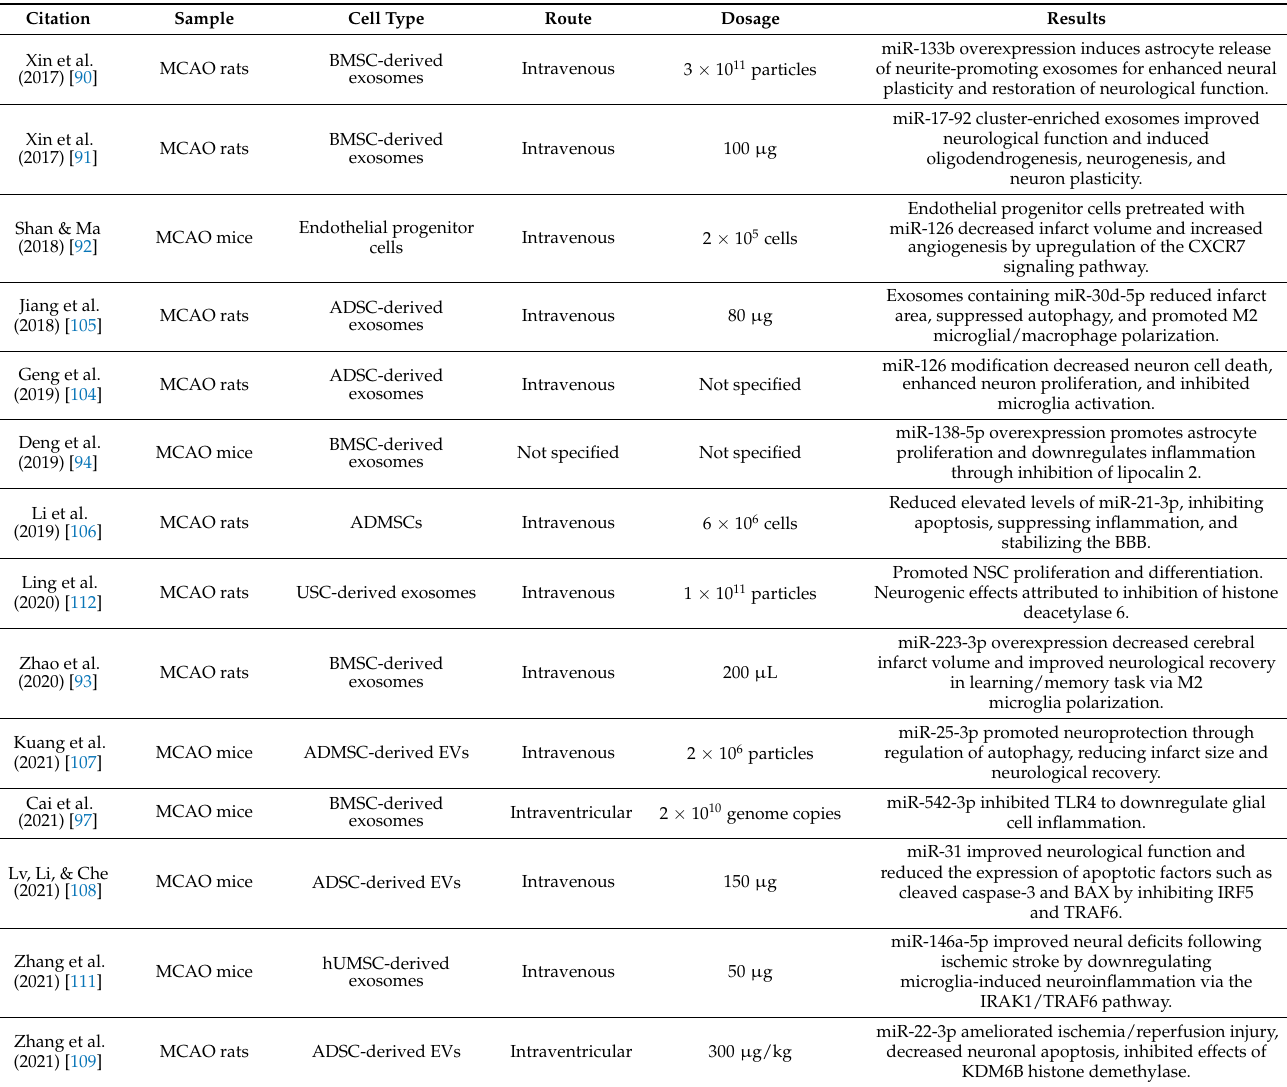
Table 2. Epigenetic Stem Cell Studies for Stroke Therapy. This table outlines cell-based preclinical trials utilizing epigenetic modifications and interactions to enhance ischemic stroke